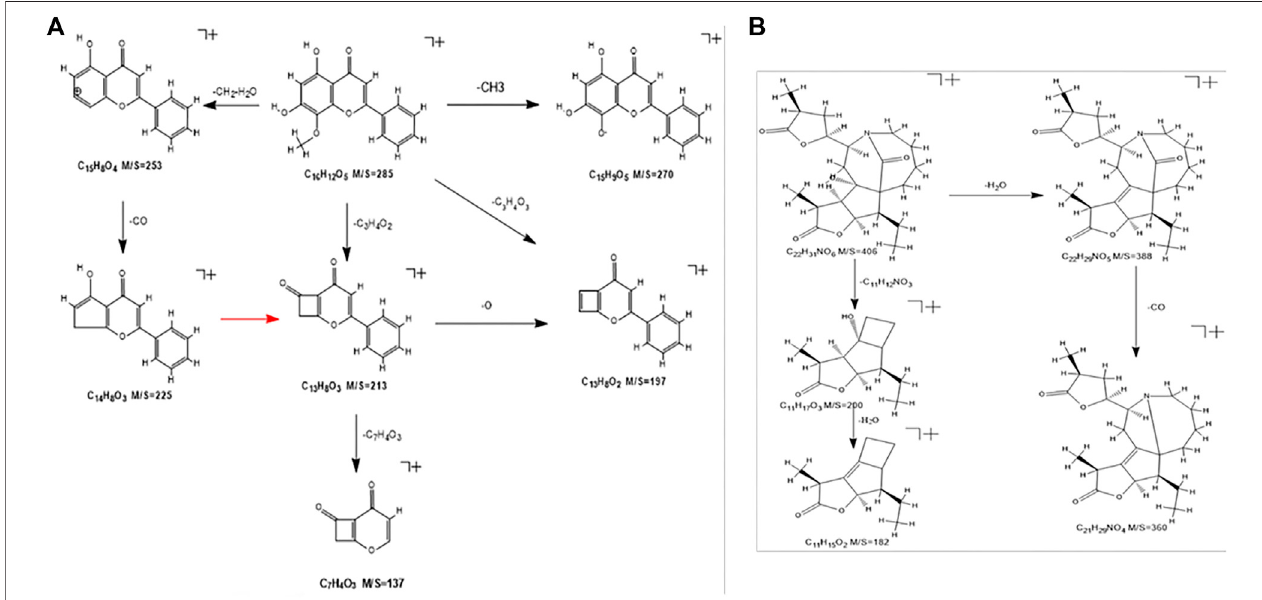
FIGURE 6 | (A) Wogonin ’ s cracking method. (B) The cracking method of Tubeostemoninol A.